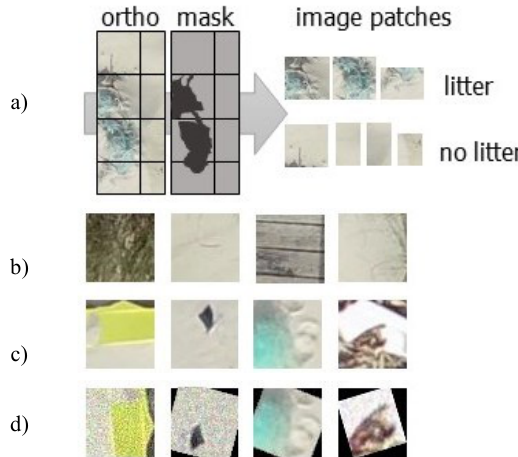
Figure 3. Examples of image samples extracted from the ortho. a) . Ortho and manually defined mask. On the right the resulting image patches, b) litter and c) oversampled litter patches (see section 3.3.2).